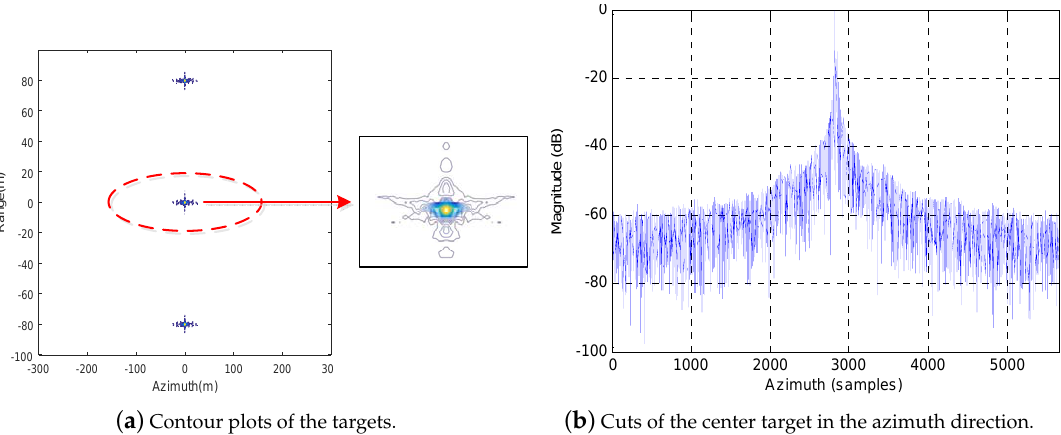
( b ) Cuts of the center target in the azimuth direction. Figure 7. The results obtained by the proposed extended subaperture imaging